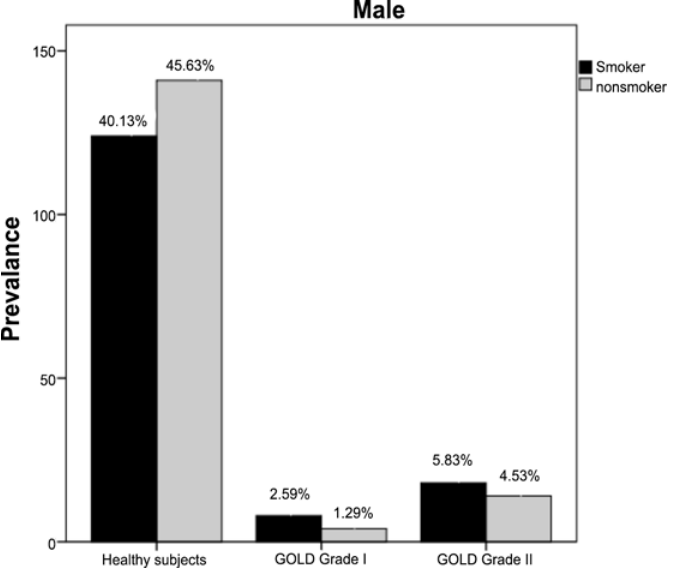
Fig 3. Population characteristics of male smokers and nonsmokers. COPD: Chronic Obstructive Pulmonary Disease; GOLD I: Global Initiative for Chronic Obstructive Lung Disease Grade I COPD; GOLD II: Global Initiative for Chronic Obstructive Lung Disease Grade II COPD.